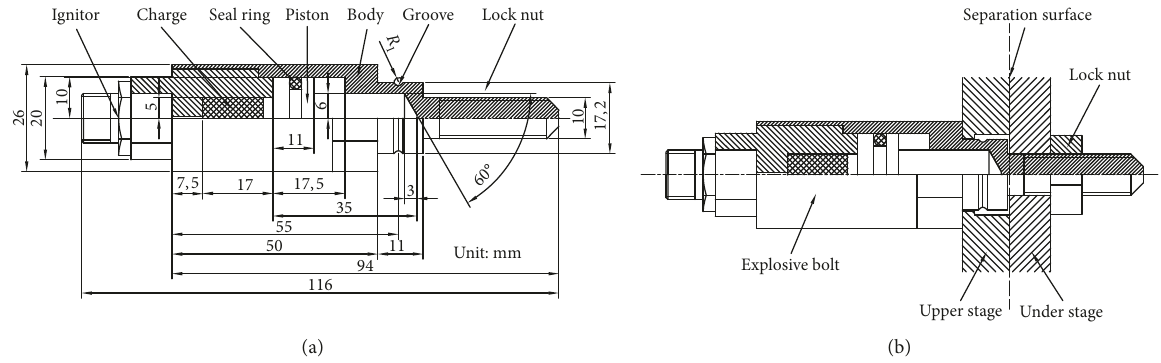
Figure 1: Schematic of a piston-type explosive bolt. (a) Structural composition and size. (b) Installation diagram.